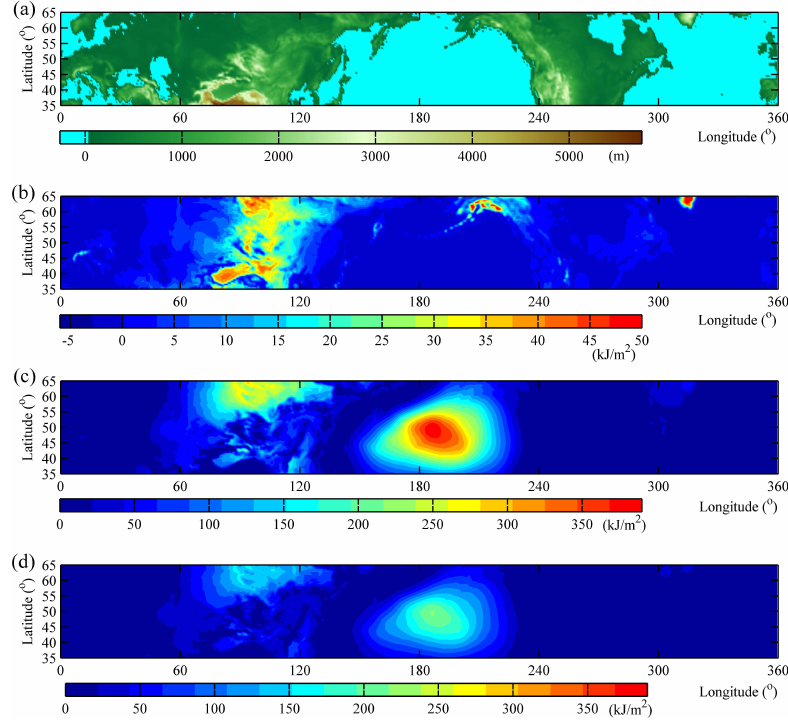
Figure 6. (a) Surface elevation z H in the northern mid-latitudes (35–65 ◦ N). Surface pressure separation-squared in Dec 2005 contributed by (b) surface topography, z H (δp H ) 2 /( 4 p H ) , and (c) enthalpy, 1 1 RT o (δp H ) 2 /( 2 p o ) , where T o = 270K and p o = 1000mb, for comparison with (c) g